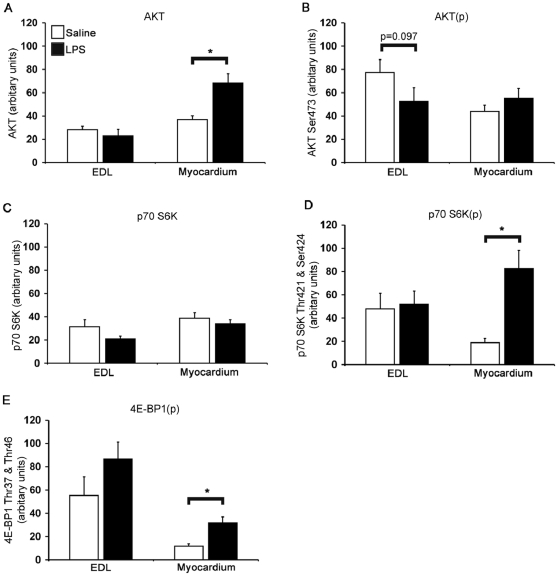
Phosphorylation and protein levels of translation initiation intermediates in muscle and myocardium following LPS infusion.Bars denote fold change in A) total AKT protein, B) phosphorylation levels of AKT residue Ser473, C) total p70 S6K protein, D) phosphorylation levels of p70 S6K residues Thr421 and Ser424 and E) phosphorylation levels of 4E-BP1 residues Ser65 and Thr70, in response to 24 h LPS administration relative to control animals. n = 8 per group. Values represent mean±SEM. * Indicates different from corresponding control (P<0.05).